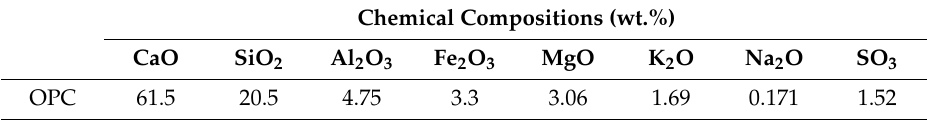
Table 1. Chemical oxide composition of Ordinary Portland cement (OPC) by XRF